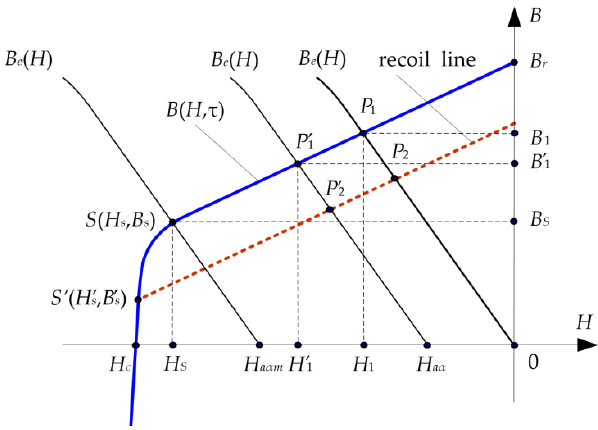
Figure 2. Demagnetization characteristic B ( H , τ ) of magnet—explanation of partial demagnetization process. The current density J from Equation (2) that appears in the winding area is not known in